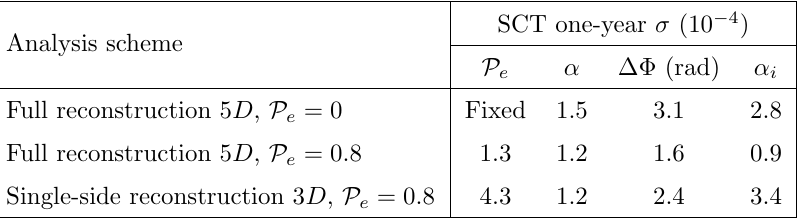
Table 1 . The expected one-year statistical precision for the parameters de(cid:12)ned in eqs. (2.16) and (2.17) and the average polarization obtained through di(cid:11)erent experimental schemes. P e Here is the decay probability density under study, (cid:16) is de(cid:12)ned in eq. (2.20), ~ (cid:16) j corre- W spond to the phase-space events, (cid:16) i correspond to the events weighted with condition M N is respected. Minimization of the likelihood function in eq. (3.1) (cid:29) is performed with the MINUIT algorithm (see ref. [14]) via the iminuit (see ref. [15]) python